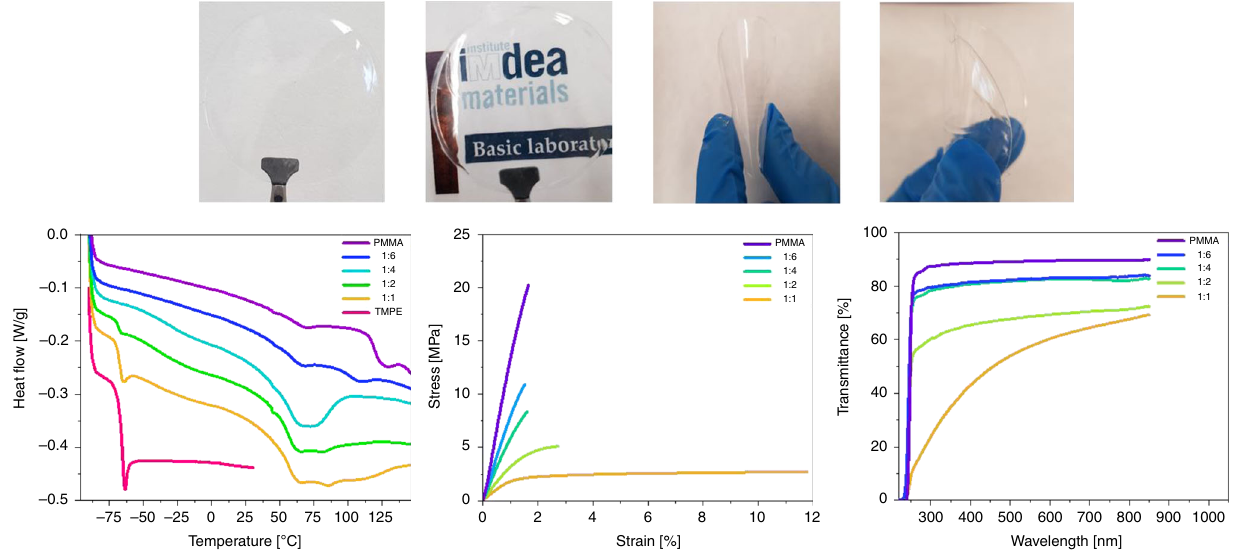
Fig. 2 Polymer composite characterization. Top: Pictures of transparent and fl exible 1:6 fi lms. Bottom: DSC (left), tensile test (center), and transmittance (right) of fi lms prepared with different mass ratios of TMPE:PMMA (see